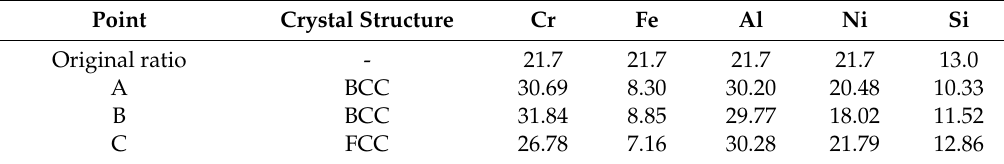
Figure 3. Morphologies of AlCrFeNiSi x high-entropy alloy ( a ) x = 0.4; ( b ) x = 0.6. Table 2. EDS analysis results of AlCrFeNiSi 0.6 high-entropy Table 2. EDS analysis results of AlCrFeNiSi 0.6 high-entropy alloy.